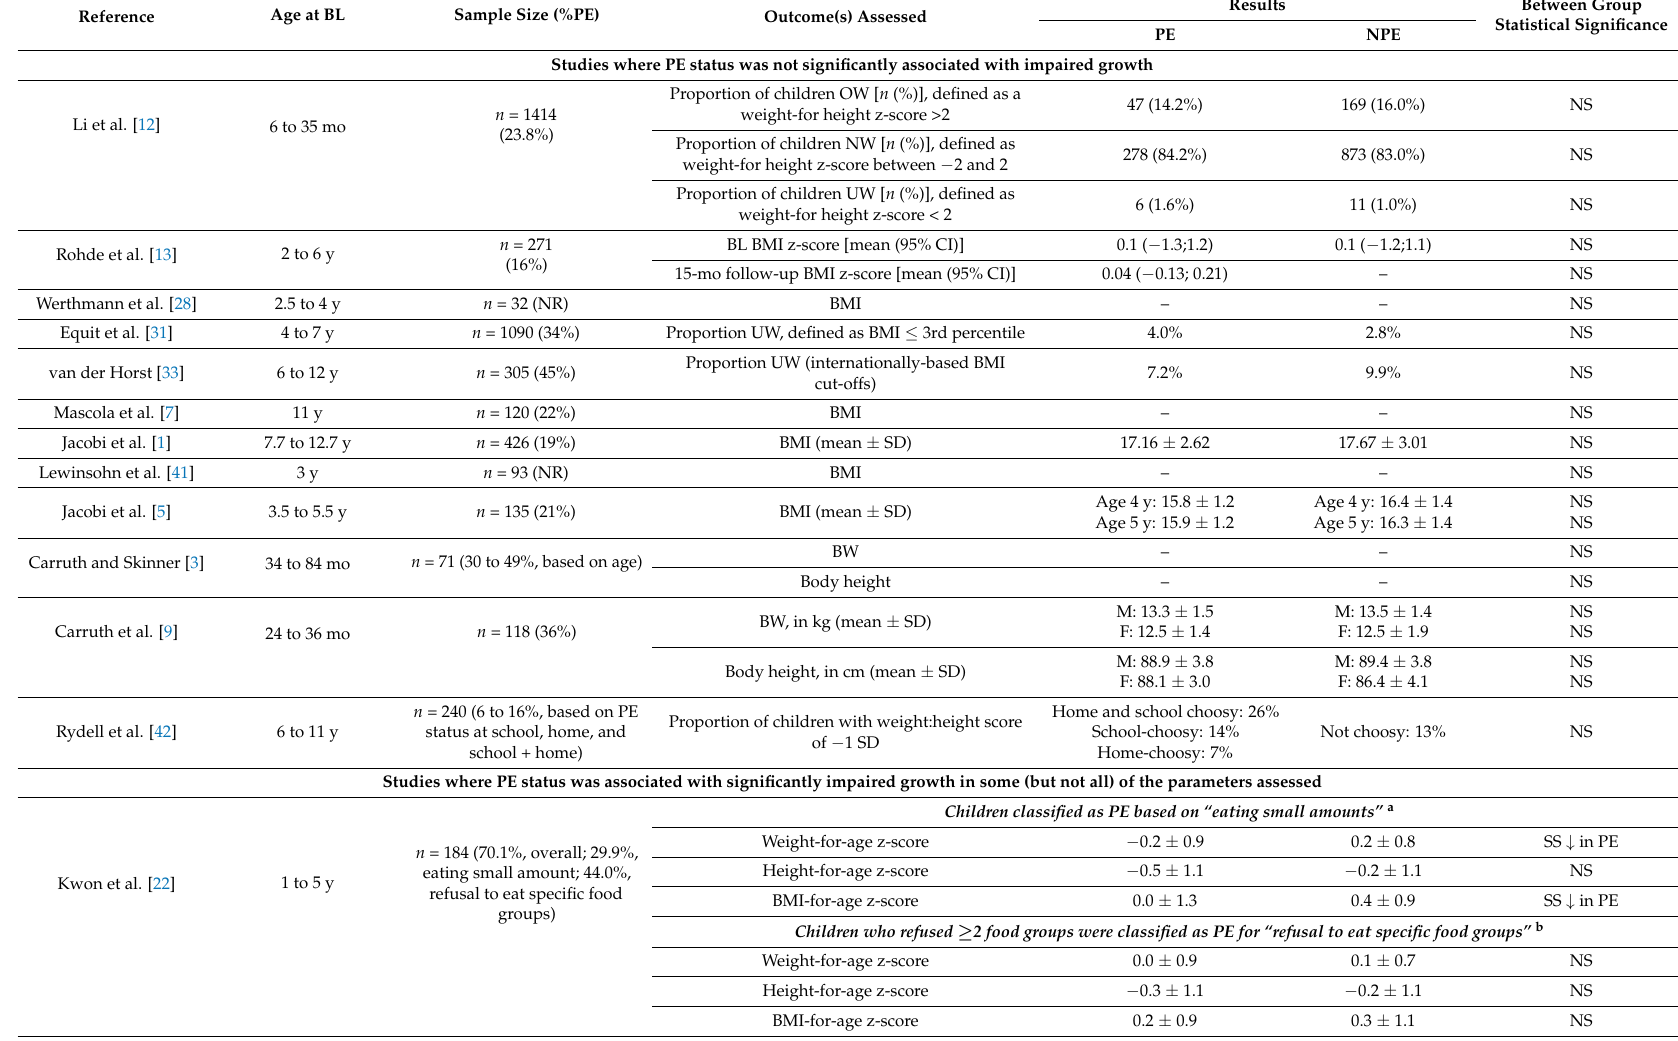
Table 9. Body weight, height, and growth status of children classified as PE versus